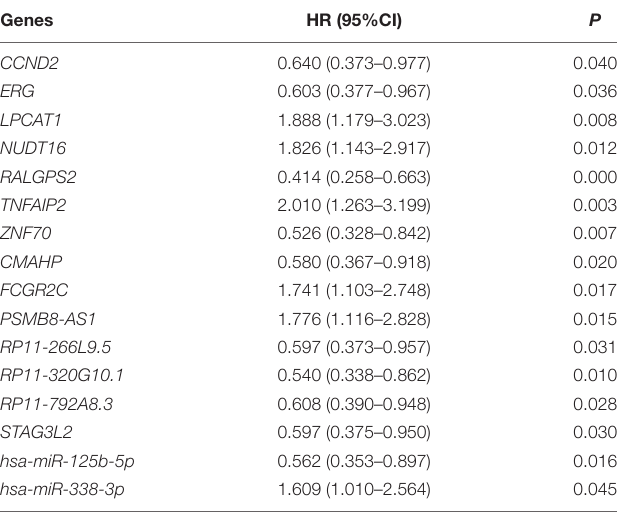
TABLE 1 | Multivariate cox proportional hazard regression analysis of 6 lncRNAs, 7 mRNAs, and 2 miRNAs.